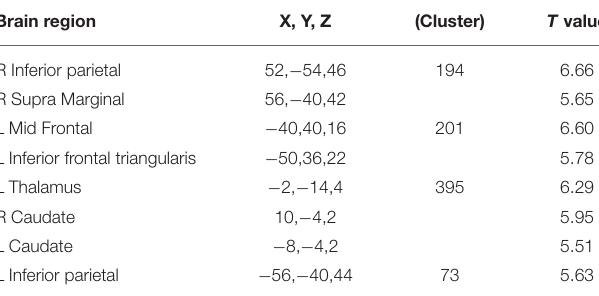
TABLE 2 | All regions showing significant activations with short inspiratory occlusions; AlphaSim corrected p < 0.05 [(uncorrected p < 0.0001, cluster size = 60 voxels), T value threshold =